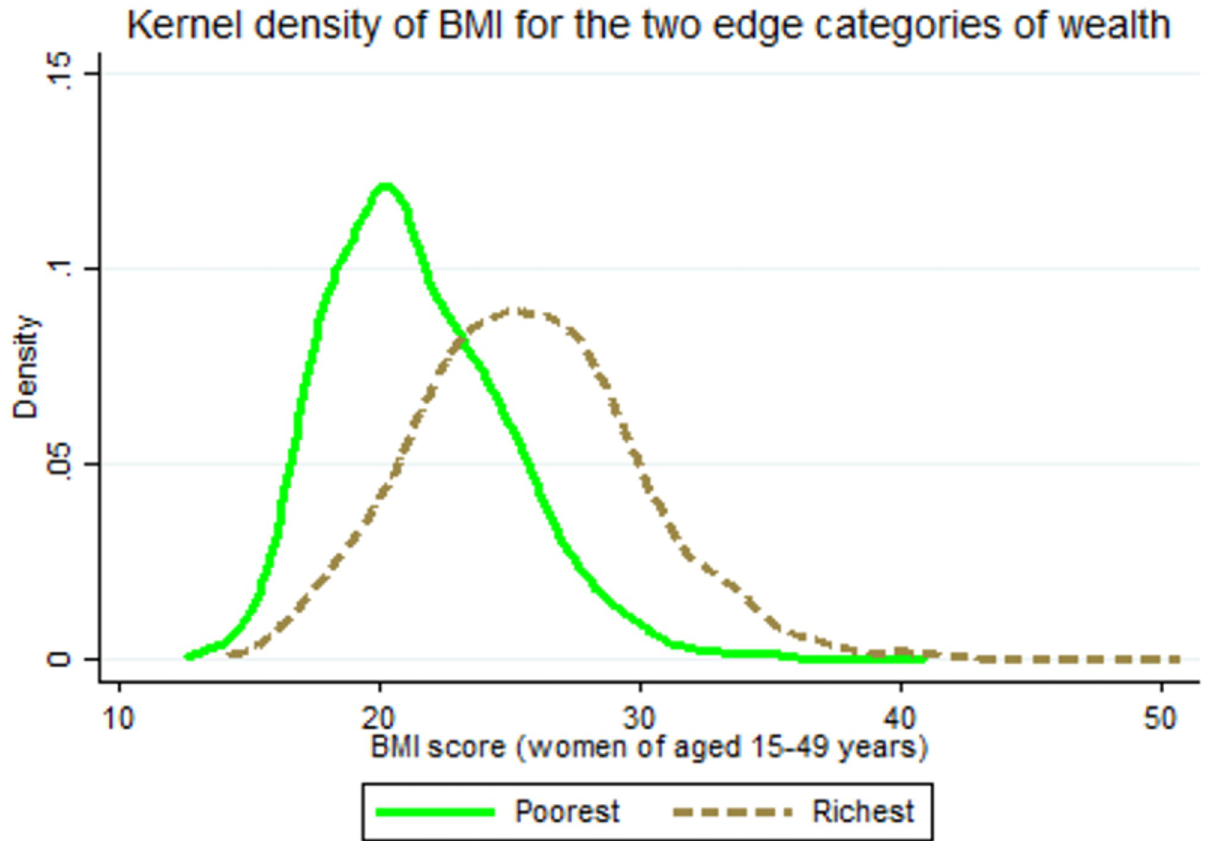
Fig 2. Distribution of body mass index (BMI) of the poorest-richest group of reproductive aged women of Bangladesh.